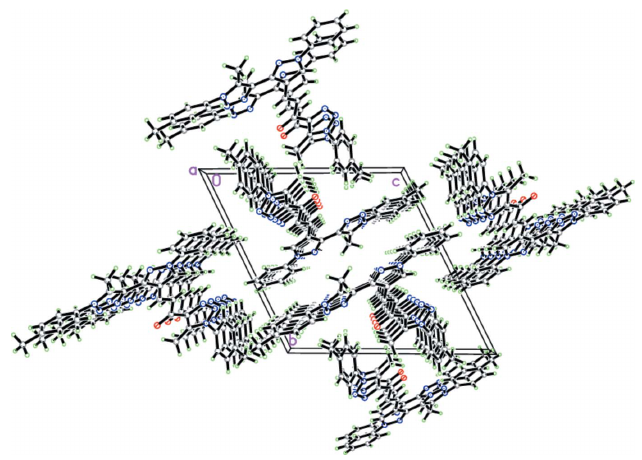
Fig. 2. Molecules are linked only by C—H (cid:3) (cid:3) (cid:3) (cid:2) interactions, forming slabs parallel to the ac plane (Table 1 and Fig. 3).